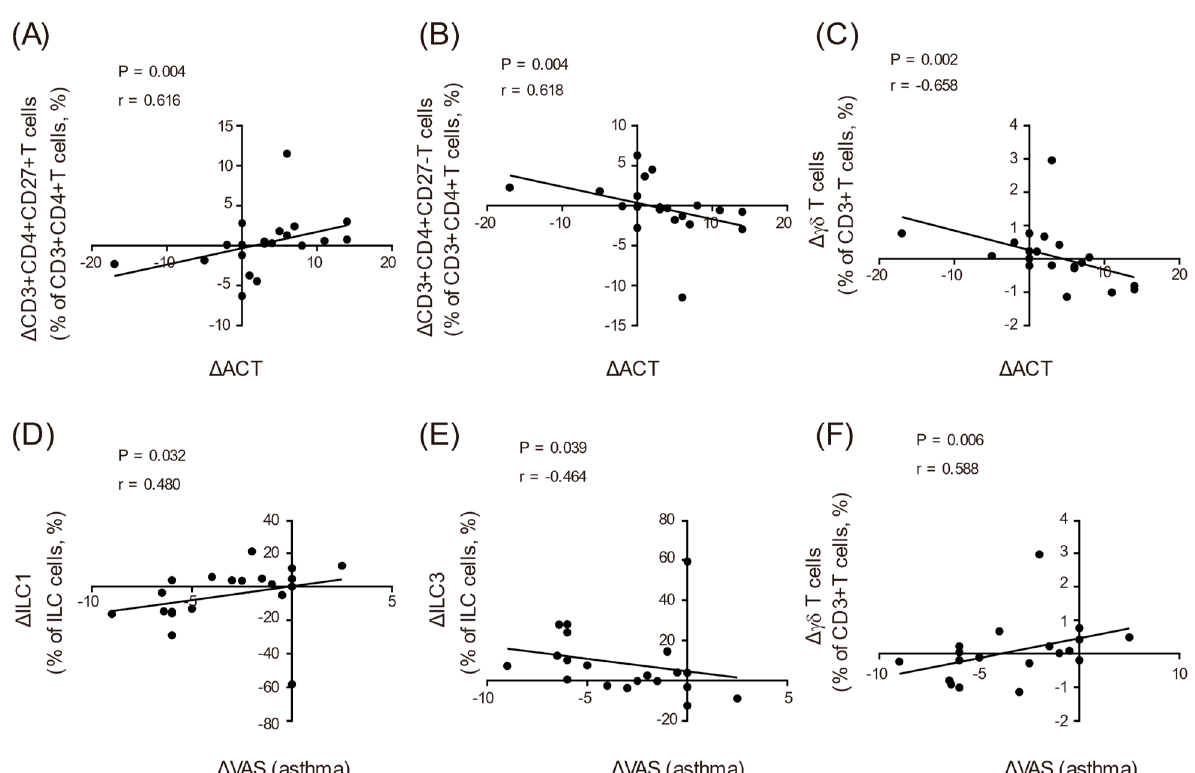
Figure 3. The change in asthma symptoms (ACT score ( A – C ) and VAS value ( D – F )) after SLIT during the in-season was associated with the change in the percentage of circulating CD27-positive CD4 + T cells ( A ), CD27-negative CD4 + T cells ( B ), γδ T cells ( C , F ), ILC1s ( D ), and ILC3s ( E ) in the off-season before and after SLIT. Abbreviations: ACT, asthma control test; ILC1, group 1 innate lym- phoid cell; ILC3, group 3 innate lymphoid cell; SACRA, self-assessment of allergic rhinitis and asthma. 4. Discussion One year of JCP SLIT in asthma patients with SAR-JCP improved their SAR-JCP symptoms and asthma symptoms based on the SACRA questionnaire and ACT scores during the JCP dispersal season. JCP SLIT also significantly improved airway resistance, decreased serum IFN- γ concentrations and circulating Treg cells, and increased circulat- ing ILC3s during the off-season. Moreover, the change in ACT scores during the season before and after SLIT was negatively correlated with the change in circulating CD27-neg- ative CD4 + T cells and γδ T cells during the off-season before and after SLIT. The change in the VAS score for asthma during the season before and after SLIT was negatively cor- related with the change in the frequency of circulating ILC3s and positively correlated with the change in the frequency of circulating ILC1s and γδ T cells during the off-season before and after SLIT. To our knowledge, this is the first study to suggest that improve- ments in asthma symptoms during the JCP dispersal season after SLIT are associated with a decrease in the frequency of circulating CD27-negative CD4 + T cells and γδ T cells and an increase in the frequency of circulating ILC3s during the off-season before and after SLIT. JCP SLIT improved rhinitis and asthma symptoms in this study, and some previous reports have suggested that treatment for rhinitis, including intranasal corticosteroid, an- tihistamines, and SLIT, improve asthma symptoms [12,16–19]. SLIT was effective for some allergic asthma and asthma exacerbations during the JCP dispersal season in Japanese patients with asthma, and SAR-JCP could be sufficiently prevented by JCP SLIT [12,20]. A study of patients with mild-to-moderate asthma coexisting with allergic rhinitis showed a control of symptoms for 16 weeks after intranasal corticosteroid therapy alone, despite